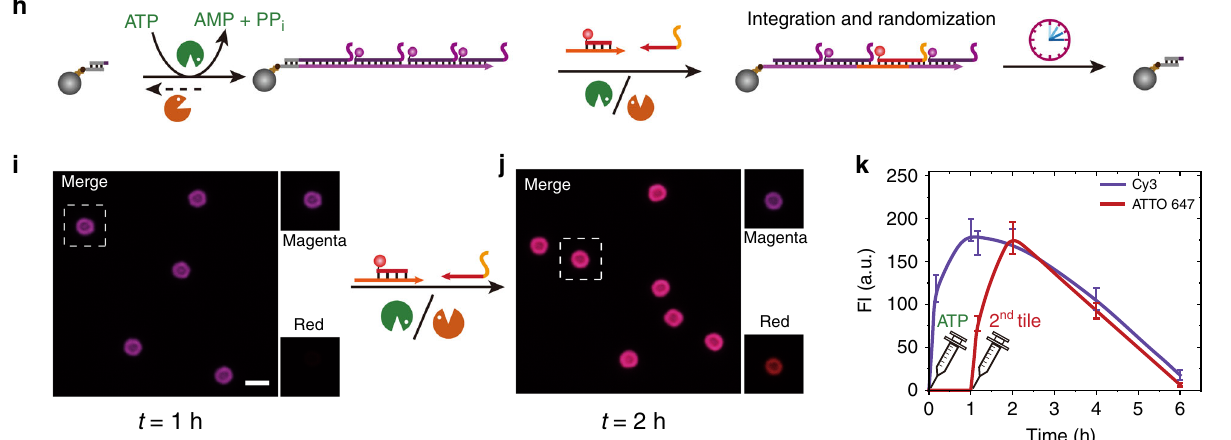
Fig. 5 ATP-fueled transient colloid assembly (TCA), and dynamic DNA surface polymerization (TSP). a Schematic illustration of DNA